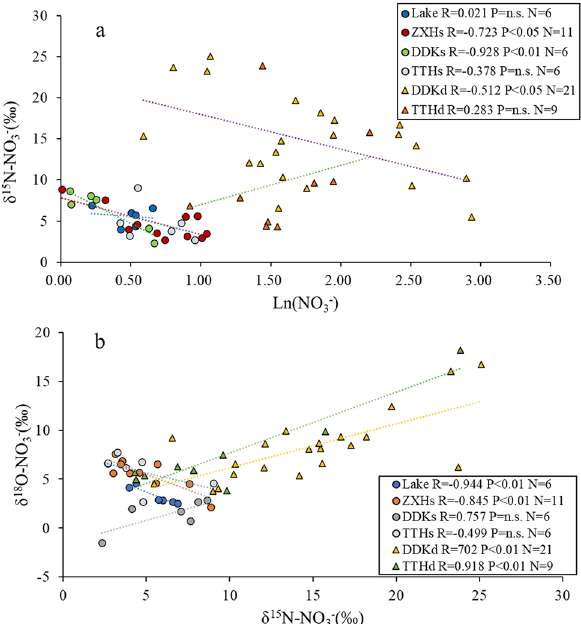
Figure 3. Relationships of δ 15 N–NO 3 − versus ln (NO 3 − ), δ 18 O–NO 3 − versus δ 15 N–NO 3 − values in Shengjin lake basin (R is Pearson correlation; P indicates that the correlation is significant at the 0.01 level (2 tails); N represents the number of statistical samples; n.s. = nonsignificant and p > 0.05).